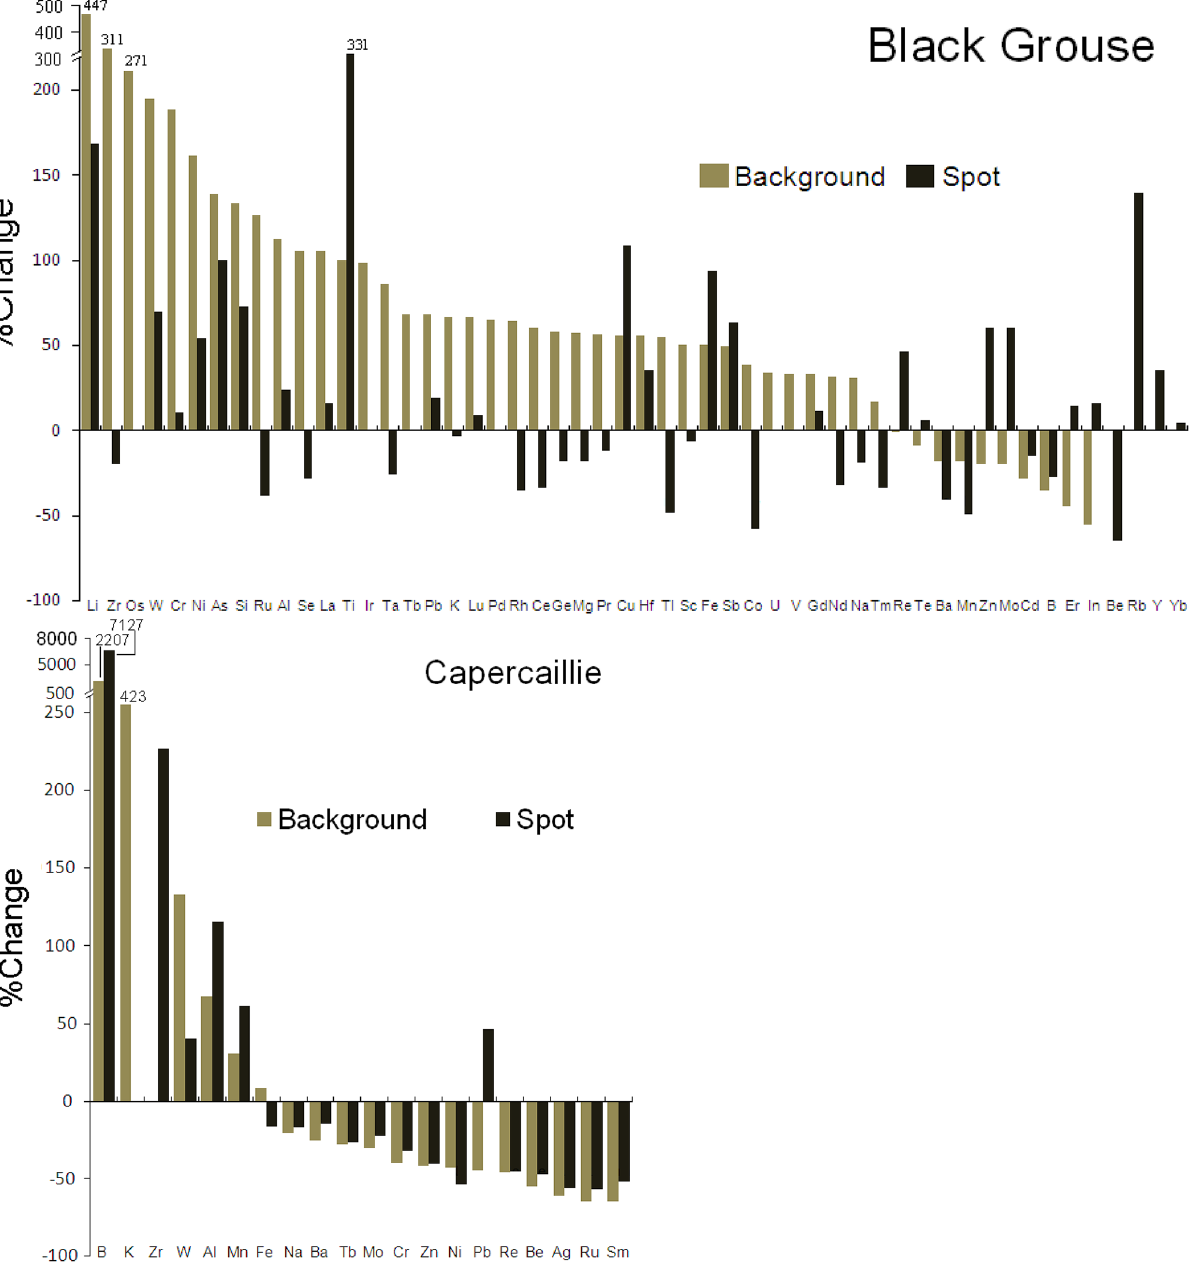
Figure 3. %Change (= Concentration post-hatched − Concentration non-embryonated × 100/Concentration non-embryonated ) in elemental concentrations in the background colour and pigment spot regions of eggshells following embryonic eggshell etching, defined as non-embryonated and post-hatched eggshells of Black Grouse Tetrao tetrix and Capercaillie Tetrao urogallus . For the elemental concentrations and sample sizes, see Tables S2and S3. Note : The bars with positive values indicate elevated elemental concentrations following embryonic eggshell etching, whereas those with negative values indicate decreases within a given shell region. Note that because of some differences in eggshell elemental concentrations related to the origin of the eggs (see “Results”), the trend in %Change calculated within the sample of eggshells from wild and captive Black Grouse and Capercaillie retains the same direction, although the magnitude (bars) of %Change becomes smaller (after recalculation of the data from Tables S4 and